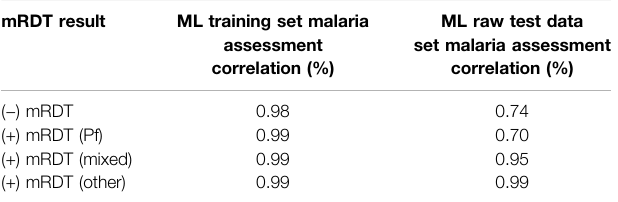
TABLE 6 | Confusion matrix for THINKMD ML malaria assessment. mRDT